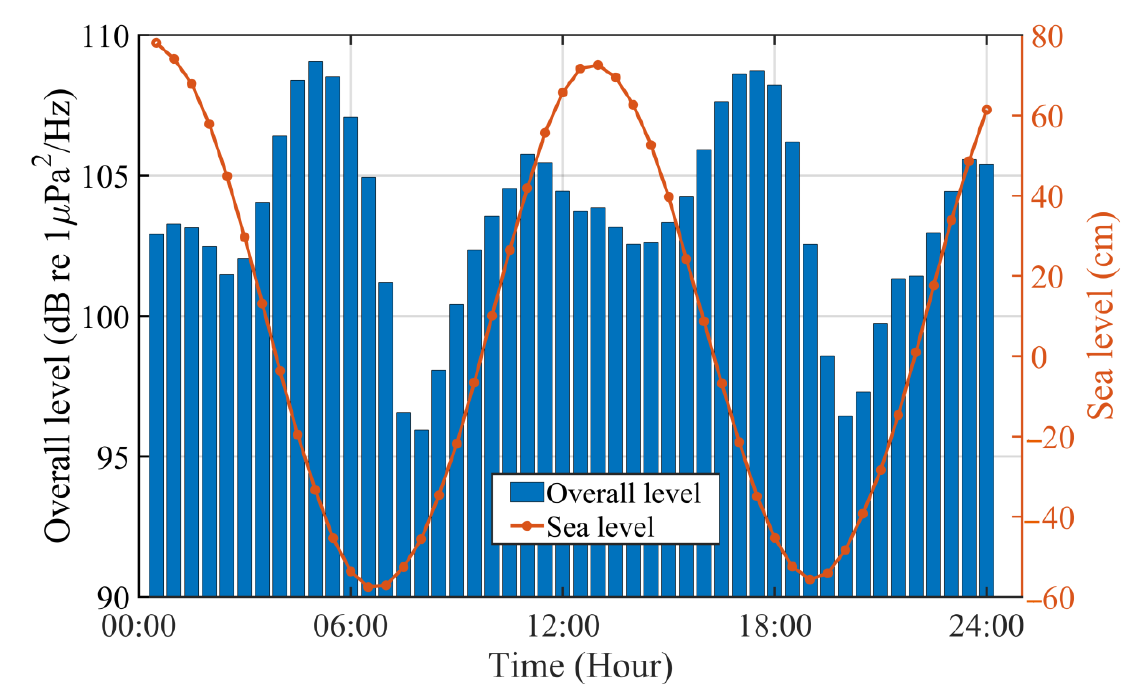
Figure 11. Sea level (red line) and overall level of underwater noise (bars) averaged at each time point over 24 h based on the timing of high tides each day from 15 May to 27 August 2013.